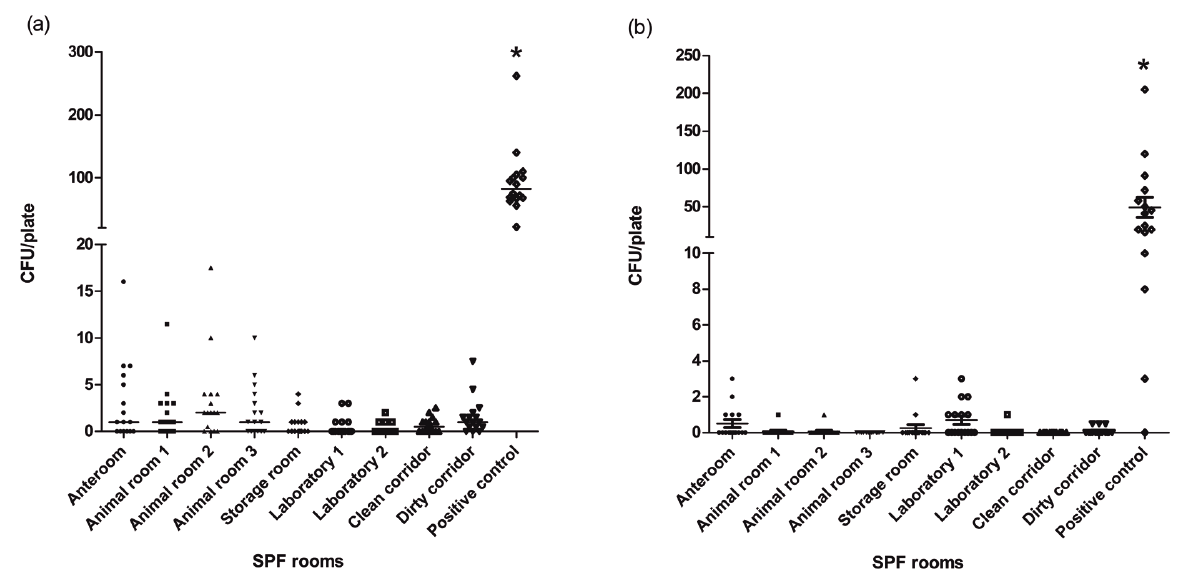
Figure 2 - Bacterial counts for TSA (a) and SDA (b) sedimentation plates. Each dot represents the CFU registered each monitoring day (16 time points). The median (horizontal bar) is indicated for each area. * p<0.01 difference from the positive control